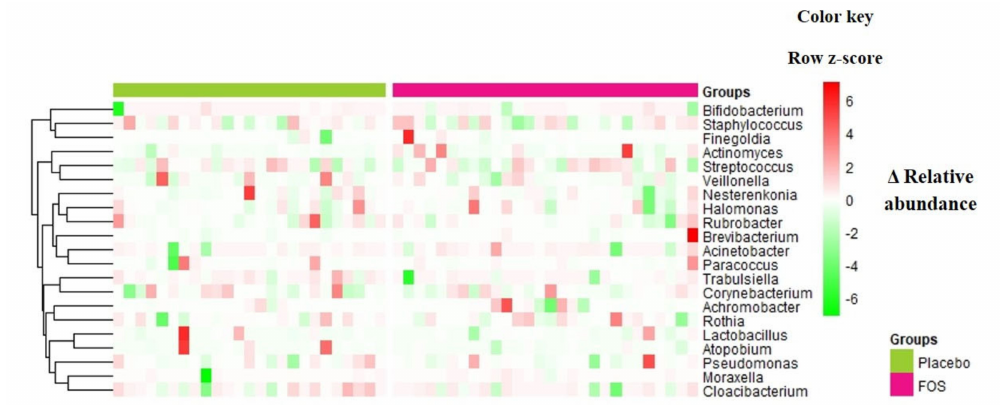
Figure 2. Delta of relative abundances of genera between the day after the intervention period and the day before the intervention, for volunteers from placebo group or FOS group. Columns correspond to di ff erences between relative abundances for each volunteer. Rows correspond to genera with maximum abundance higher than 0.05. Delta was calculated by [(relative abundance of genus at day after supplementation)–(relative abundance of genus at day before supplementation)], therefore, positive values (red) denote an increase of the relative abundance of the taxa along the intervention period, while negative values (green) denote a decrease of the relative abundance of the taxa in the milk samples. The intensity of the colors represents the degree of di ff erence between the means. The values were z-scores transformed by row for ease of visualization of the di ff erences. Rows are clustered by Euclidean